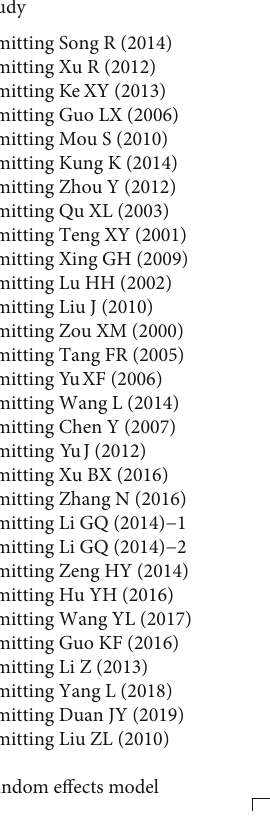
Supplement Table S1: methodological quality assessment results for the included studies. Supplement Figure S1: fun- nel plot of estimation of DN prevalence. (Supplementary